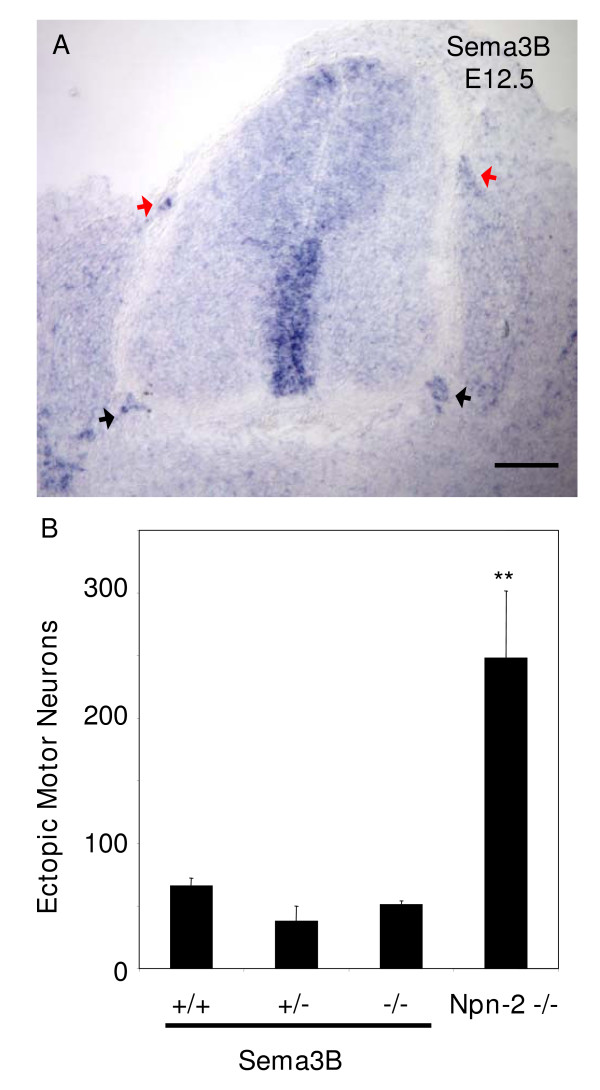
Genetic ablation of Sema3B in the mouse does not lead to ectopic positioning of spinal motor neurons. (a) As seen in the chick, in the E12.5 mouse trunk, Sema3B is expressed by BC cells located at the spinal cord DREZ (red arrows) and MEP (black arrows). Bar = 100 μm. (b) A quantitative analysis of the incidence of ectopic motor neurons at hindlimb level reveals that there is no significant difference between E12.5 Sema3B null mice and heterozygous and wild-type littermates (n = 3 each). This is in sharp contrast to E12.5 Npn-2 null mice, which is included for comparison (n = 4). **P ≤ 0.01; two-tailed t-test.